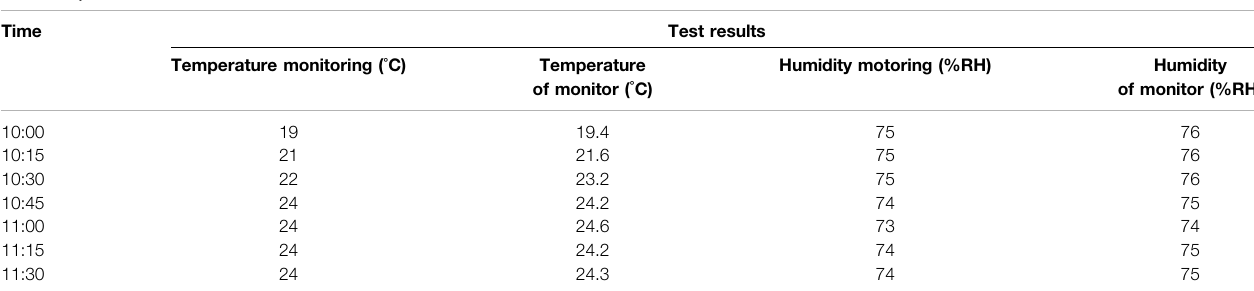
TABLE 1 | Test results Time Test